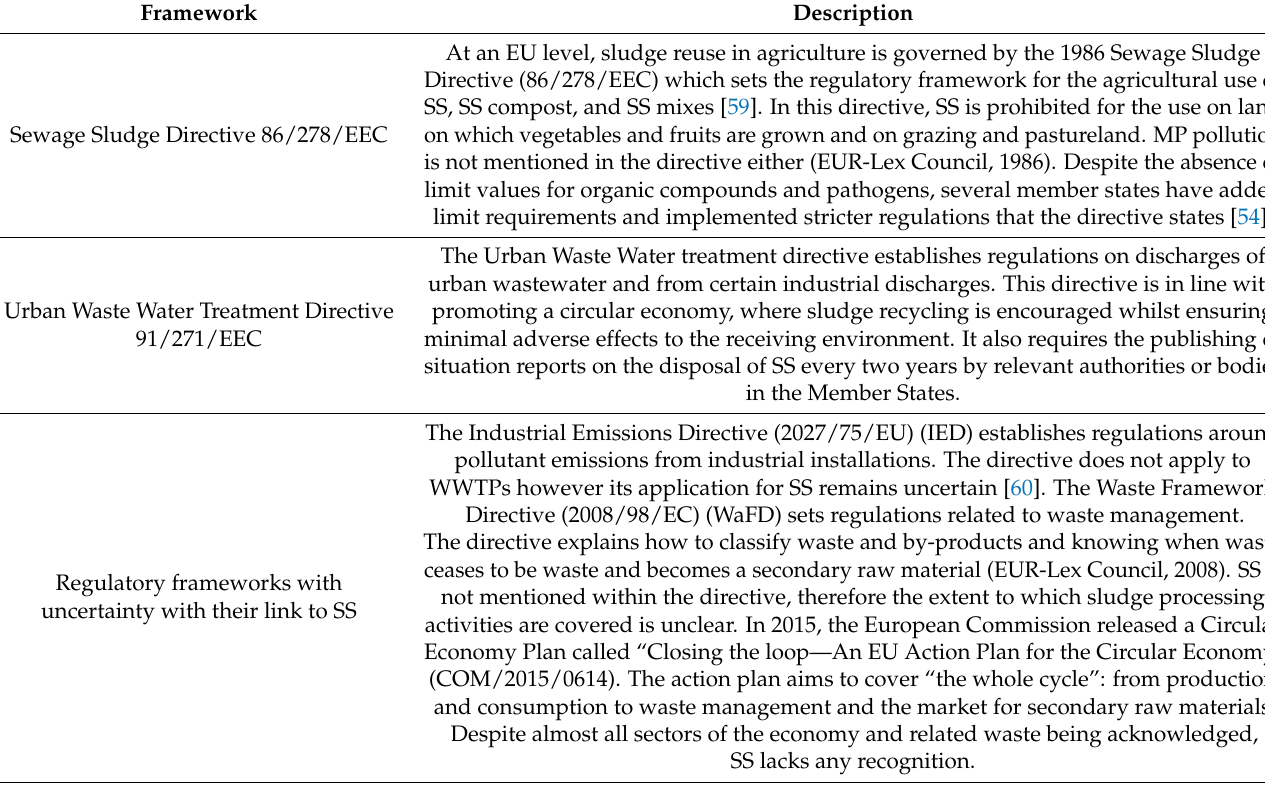
Table 5. Frameworks examining EU policy surrounding SS